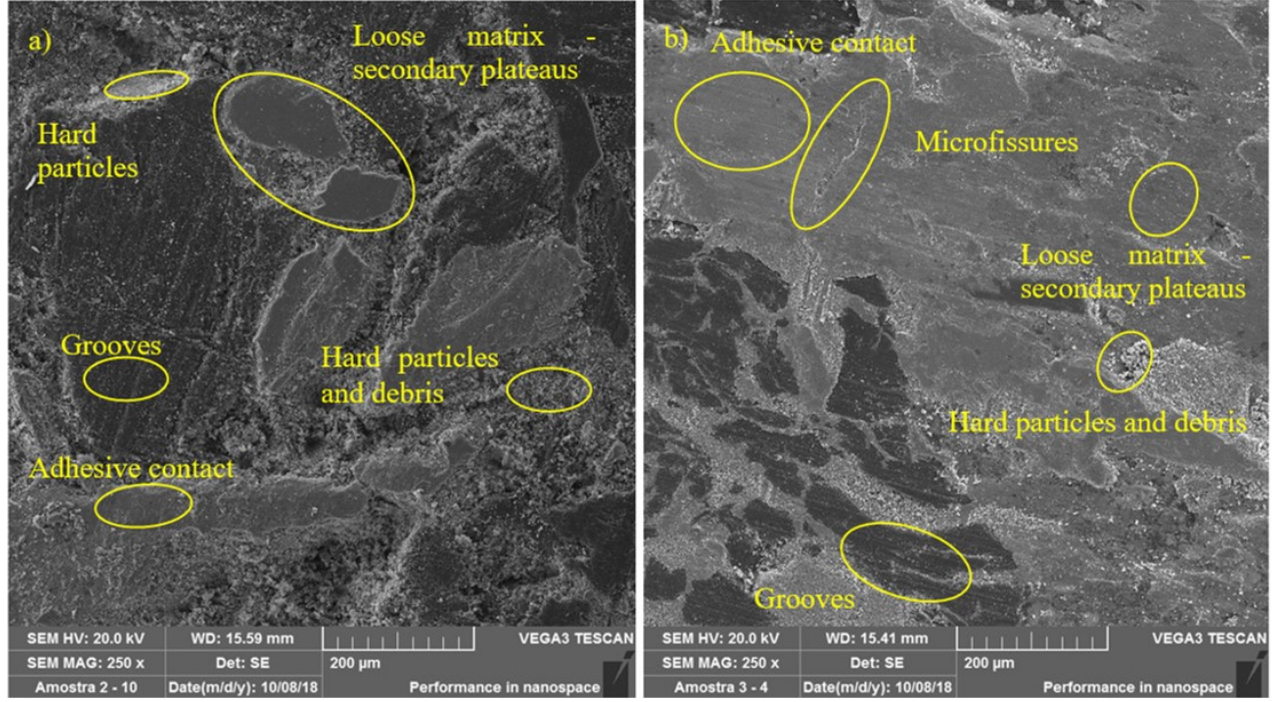
Figure 11. Wear mechanisms—( a ) simulated downhill; ( b ) emergency braking.